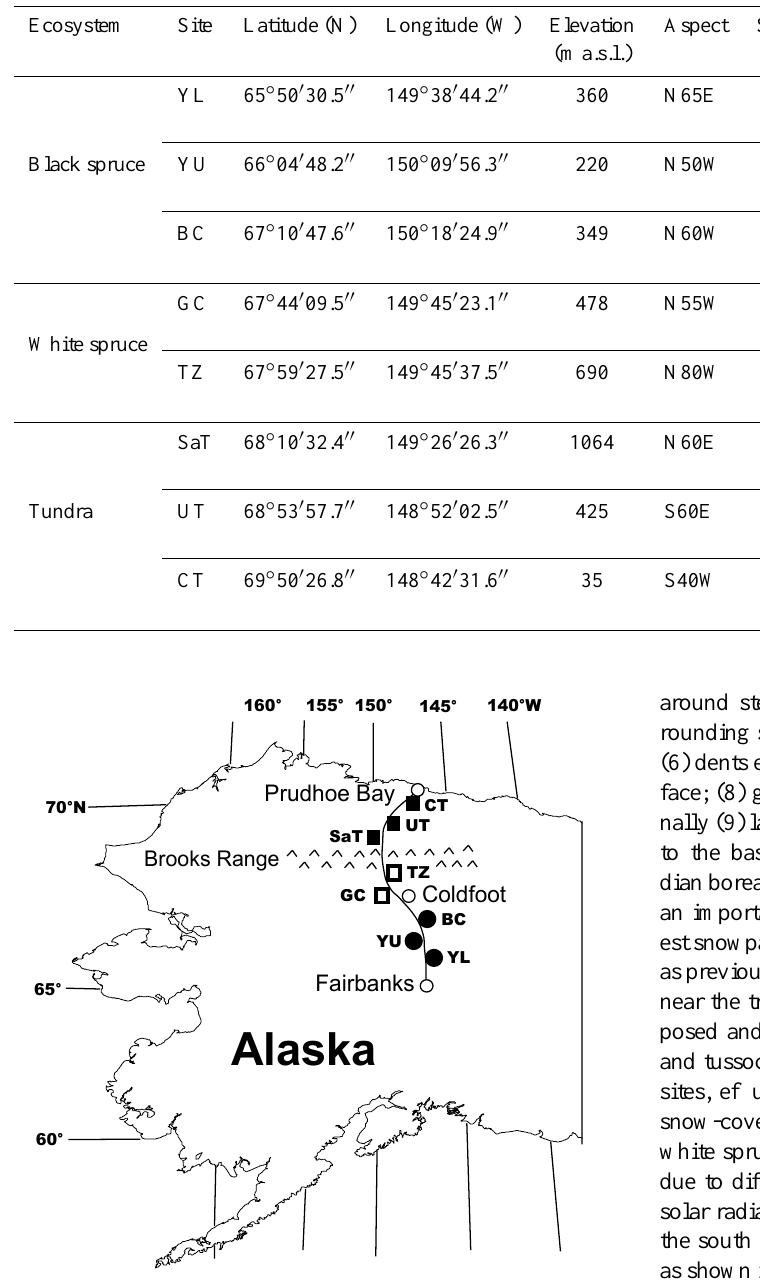
Table 1. Site information for black spruce, white spruce, and tundra sites across the haul road of Alaska during the winter and spring seasons of 2010–2012.